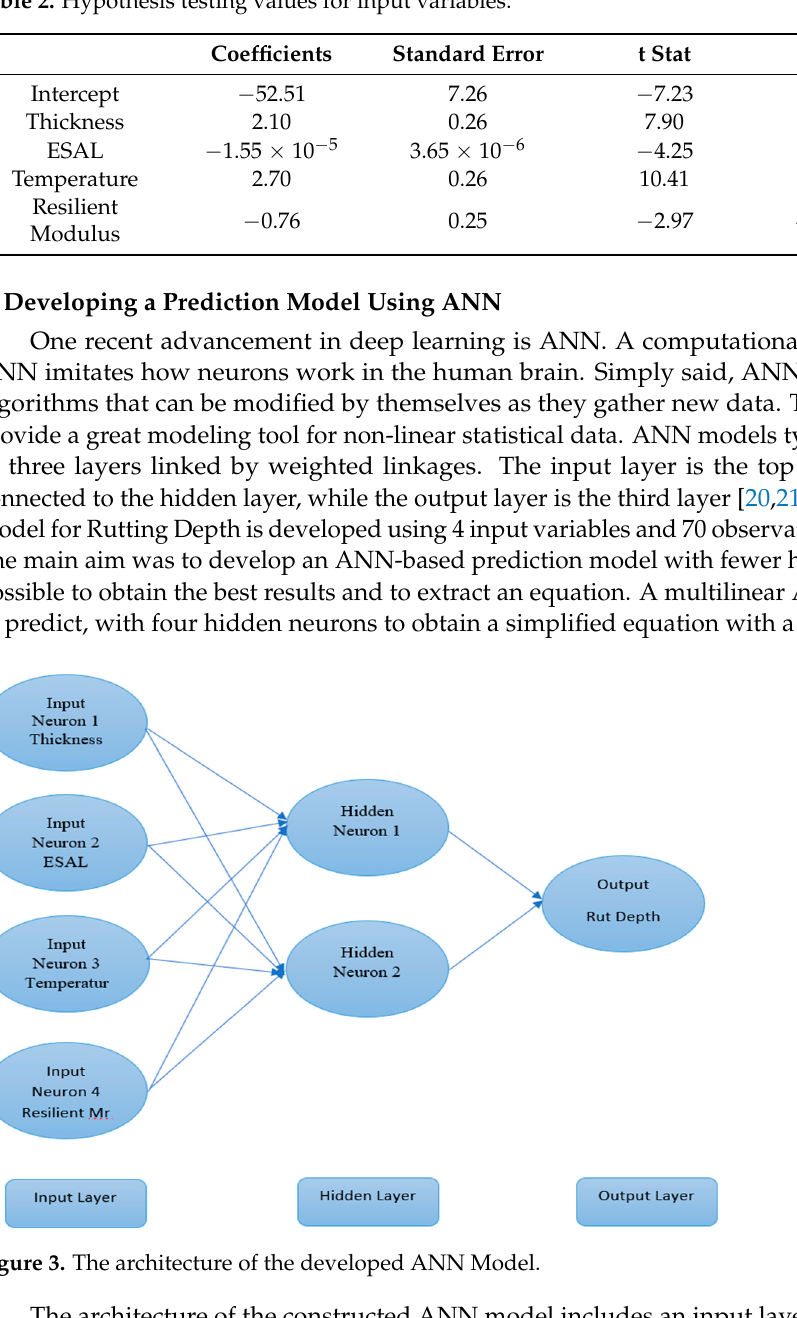
Figure 4. Flow Chart for use of data for Training, Validation, and Testing. Every input was normalized between [ − 1,1] to reduce the in fl uence of variables with a huge numerical value. The normalized output is then fi nally denormalized to obtain the actual output value. The ANN algorithm allocates weights and biases at random in the fi rst iteration. Then, the model ’ s output is compared to the training observations meas- ured data. The error is the di ff erence between the ANN model output and the measured output. The goal of the training was to reduce the Mean Square Error (MSE) as much as possible by altering the weights and biases with each iteration. Backpropagation was used to modify the weights and biases. An epoch is a unit of time that includes both forward and backward propagation. With each epoch, the model ’ s MSE is improved. Figure 5 shows that the best performance of the model was at the 19th iteration with 2.2375 MSE.